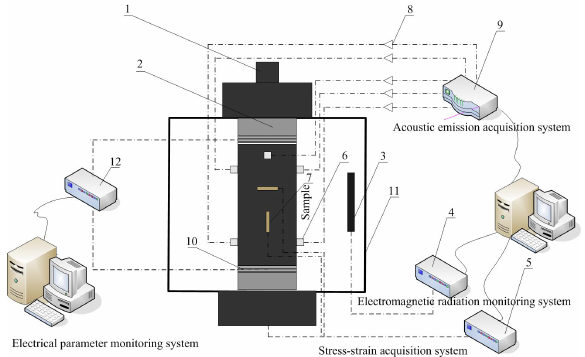
Fig. 1. Structure of acoustic-electrical experimental system for loaded coal or